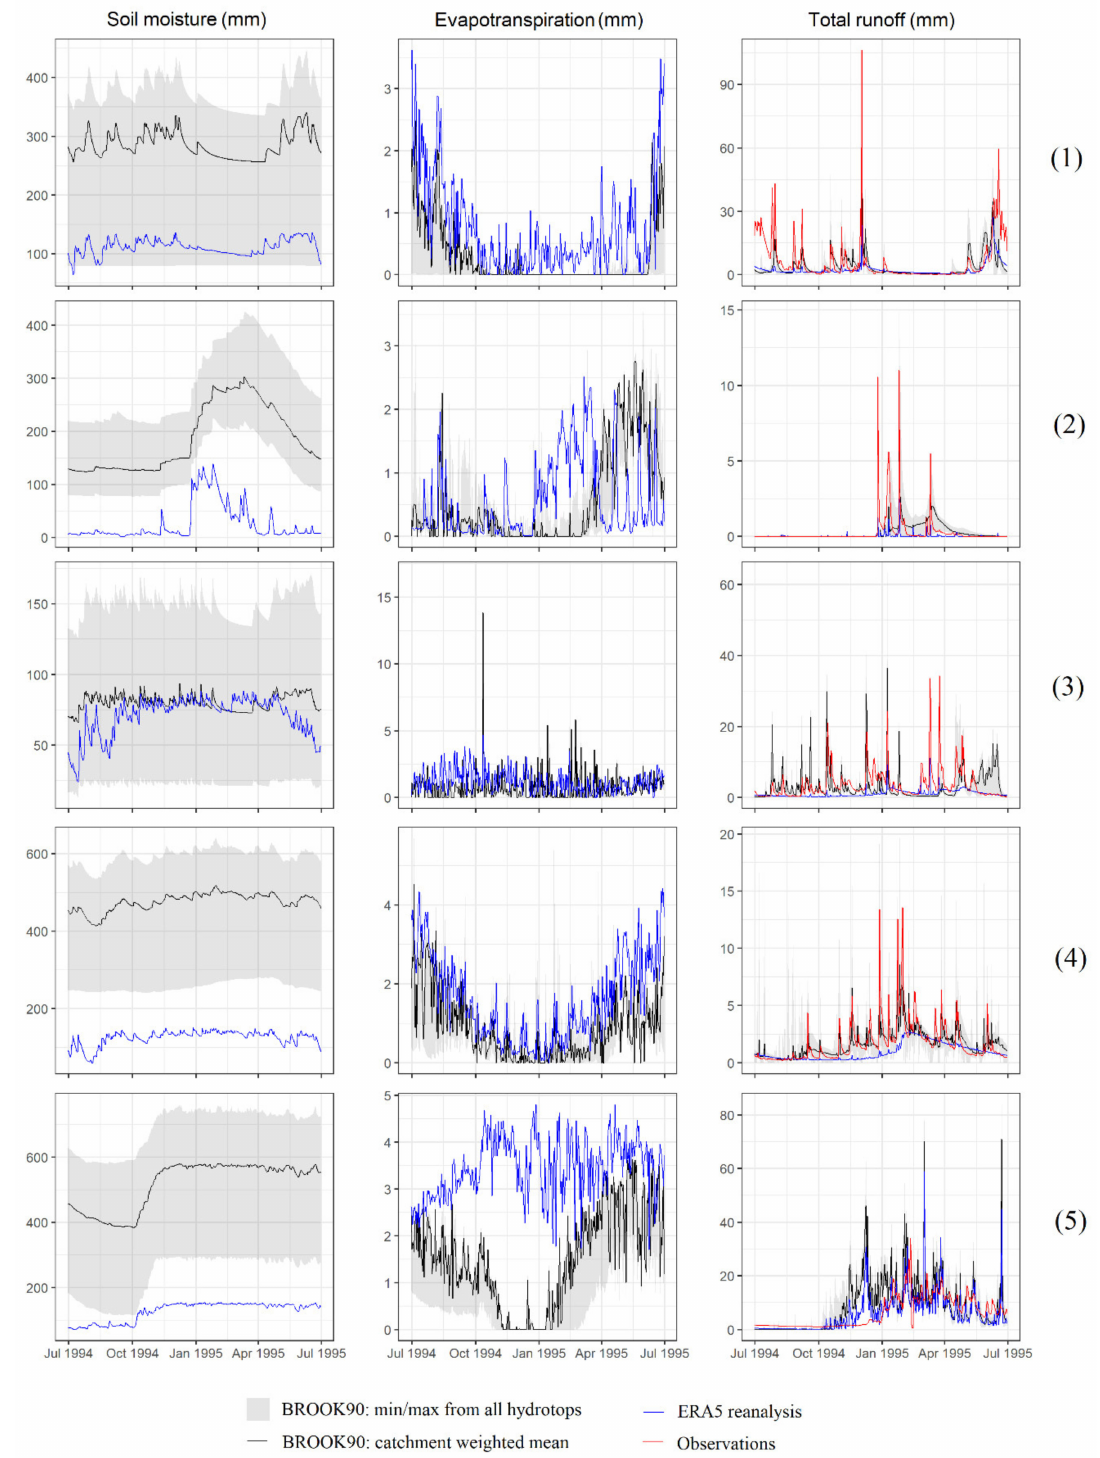
Figure 6. Daily time-series of modeled (weighted mean and maximum / minimum range from all hydrotopes) soil water content, evapotranspiration, and runo ff (overlapped with observation line) for the chosen catchments (numbers on the right side refer to Table